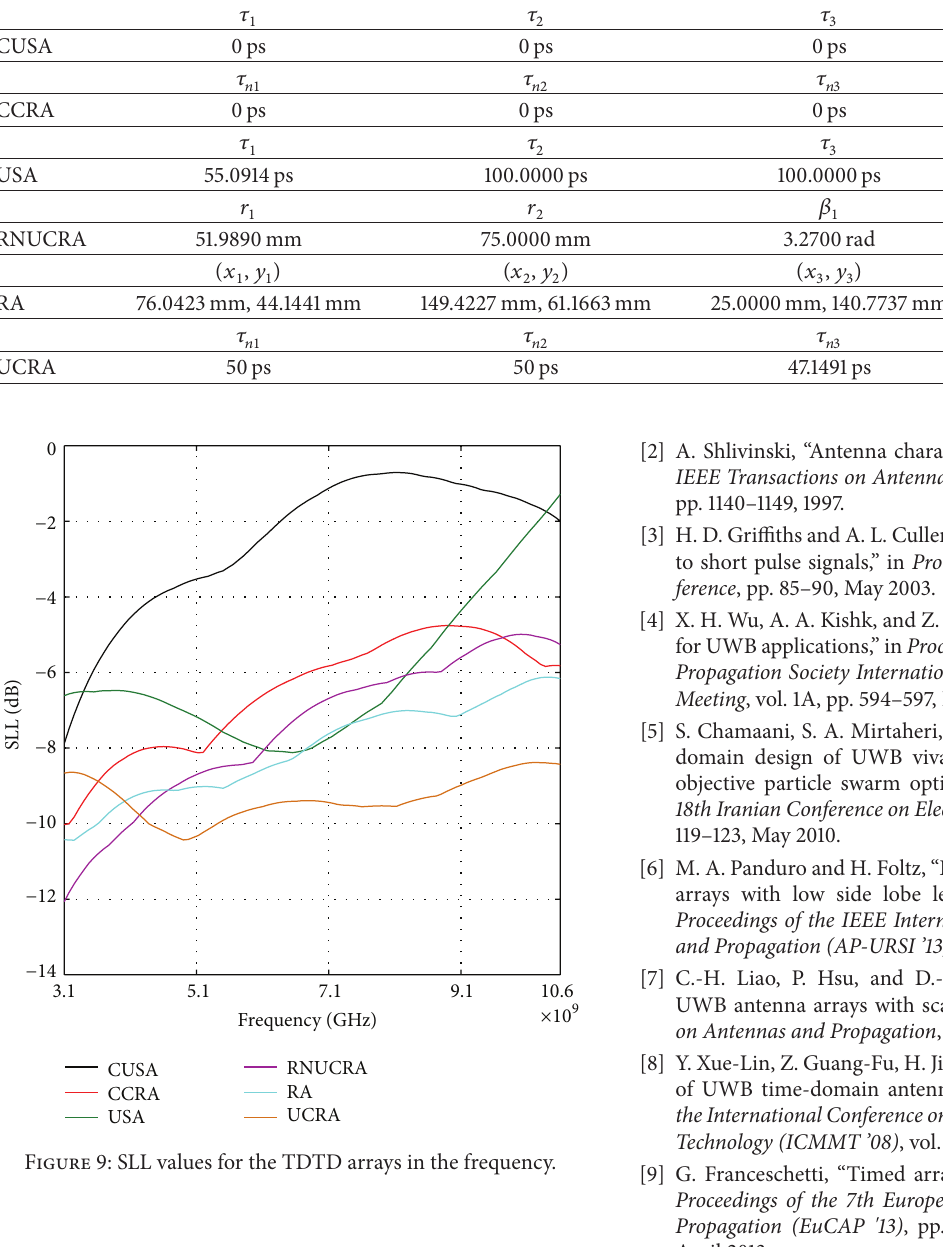
on the study of these types of arrays by including the bit error rate performance in an UWB